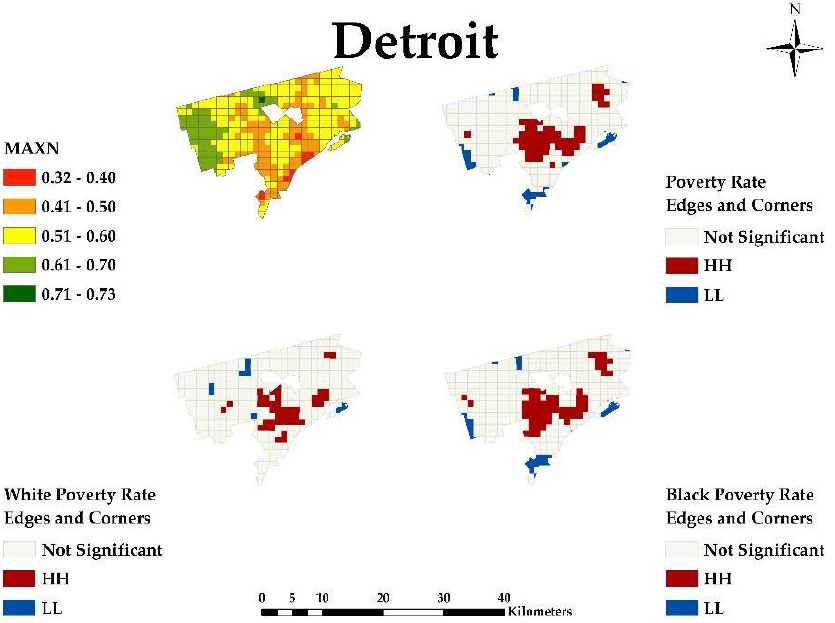
Figure 3. The LISA maps of Detroit shrinking city: MAXN, Poverty Rate, White Poverty Rate, and Black Poverty Rate.